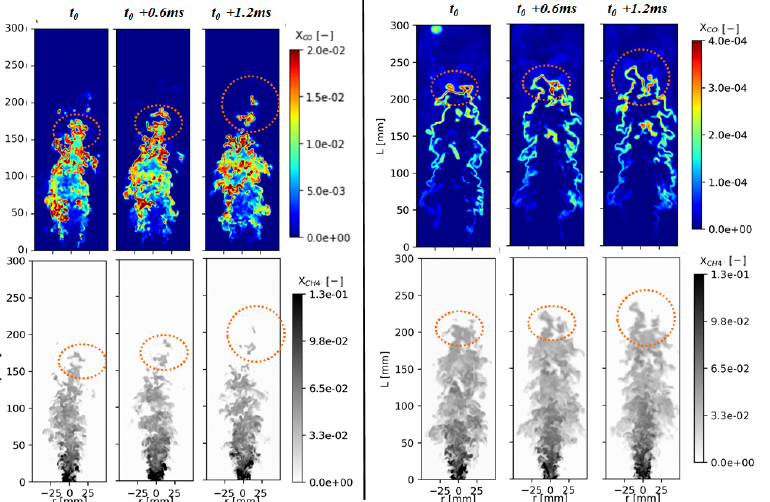
Figure 16. Sequence of instantaneous maps of X CH the FGM-EXT ( left ) and the TF ( right ) models. Circles indicate the reactive regions being trans- ported